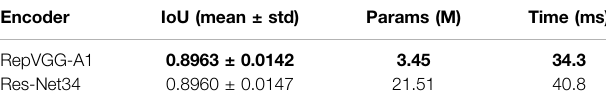
Bold represents the best result.